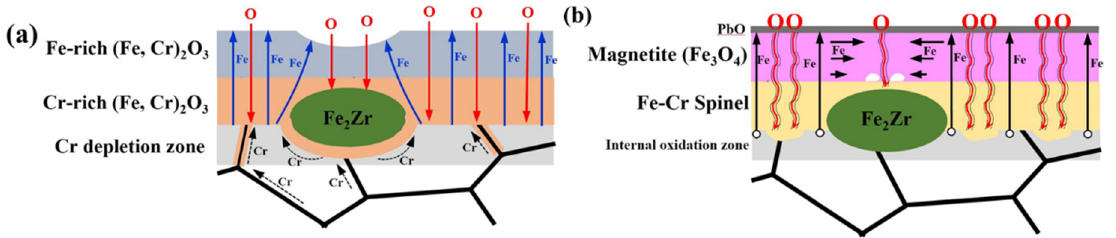
Figure 12. The schematic illustration of oxidation mechanism of Fe-Cr-Zr alloy after oxidation ( a ) in air and ( b ) in oxygen-saturated liquid Pb-Bi eutectic.